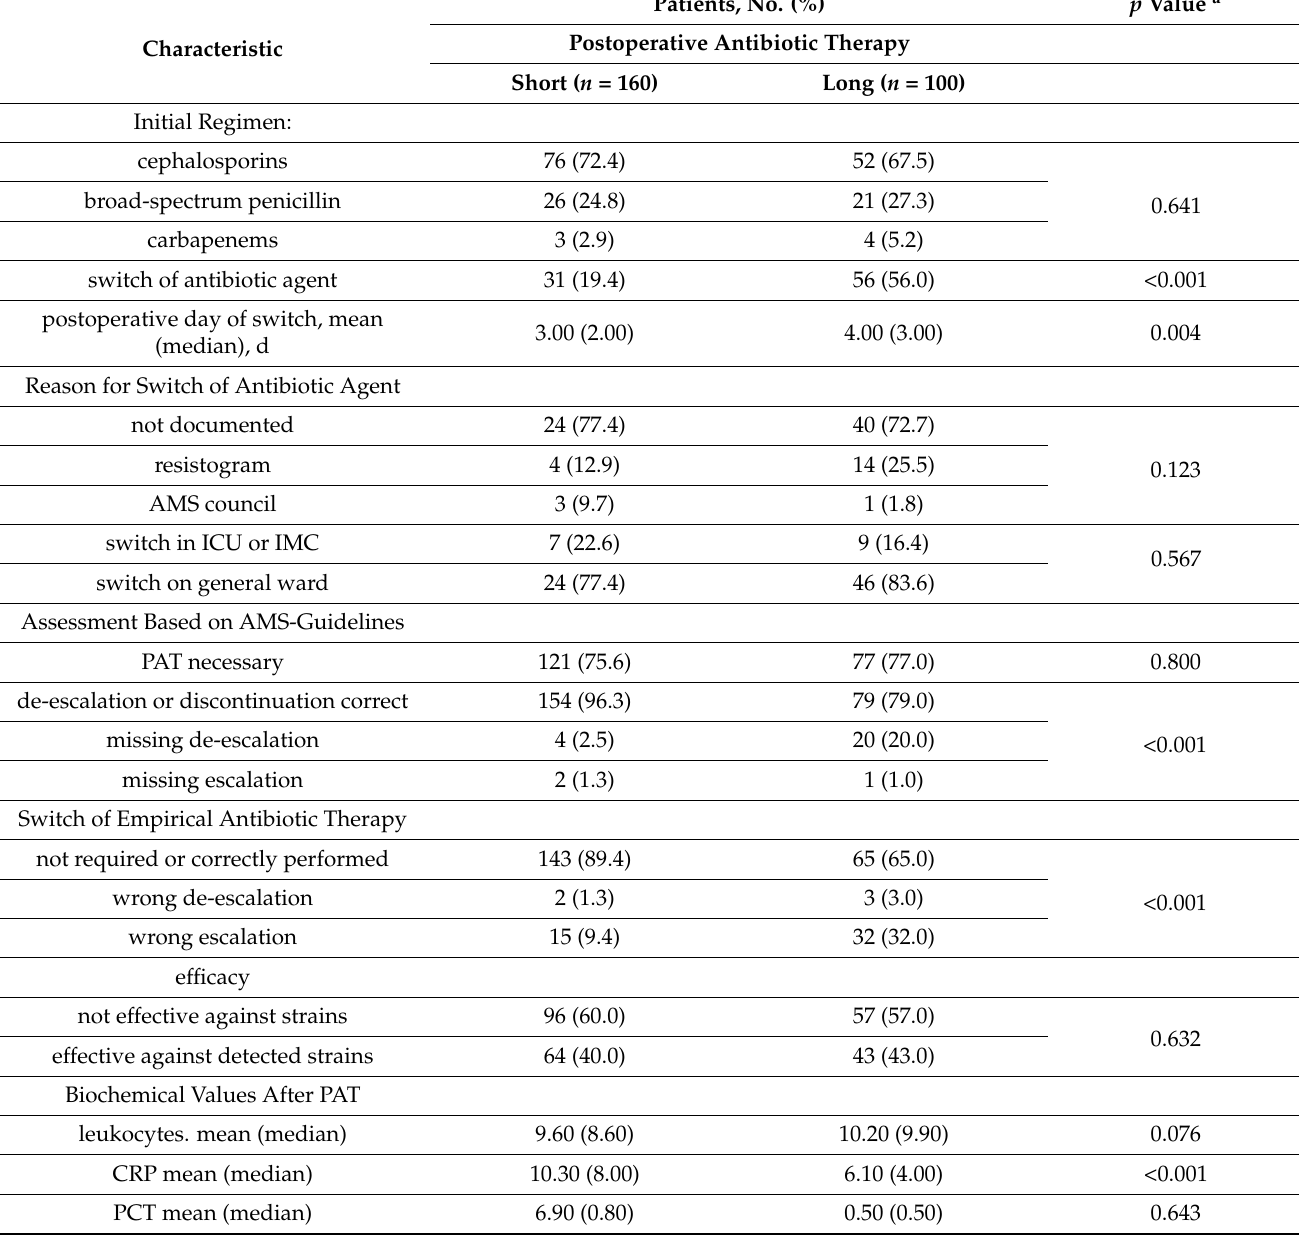
Table 3. Postoperative antibiotic